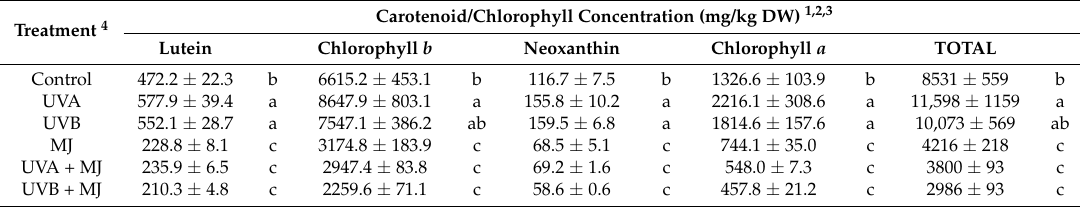
Table 6. Concentration of carotenoids and chlorophylls in broccoli sprouts treated with UVA or UVB light, methyl jasmonate, or a combination of